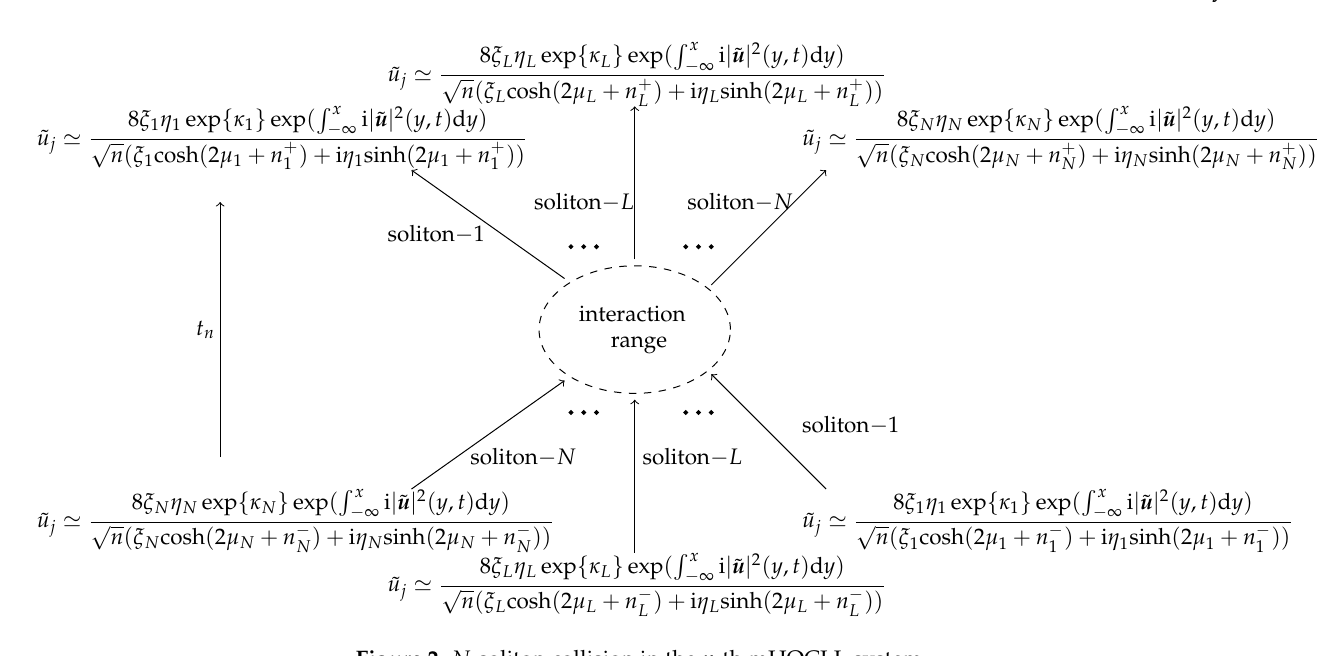
Figure 2. N -soliton collision in the n -th mHOCLL